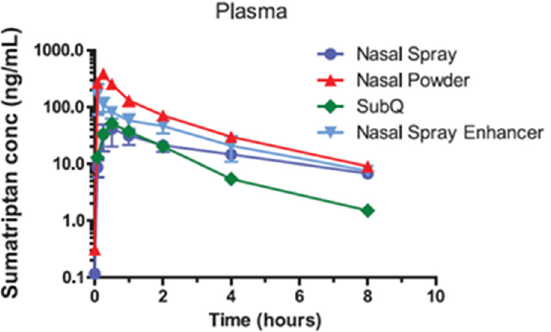
Figure 2. Pharmacokinetic profiles in NHP of sumatriptan when delivered as a nasal liquid spray, a nasal powder, a sub-cutaneous injection, and aqueous nasal spray with permeation enhancer [7].